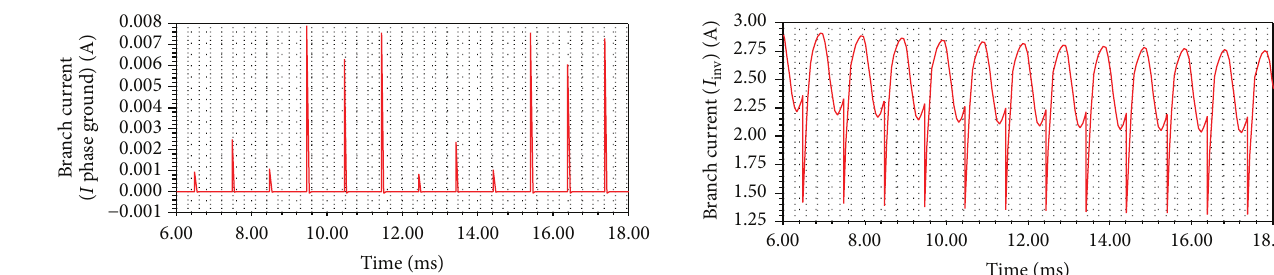
Figure 13: The inverter input current (with LCL filter).